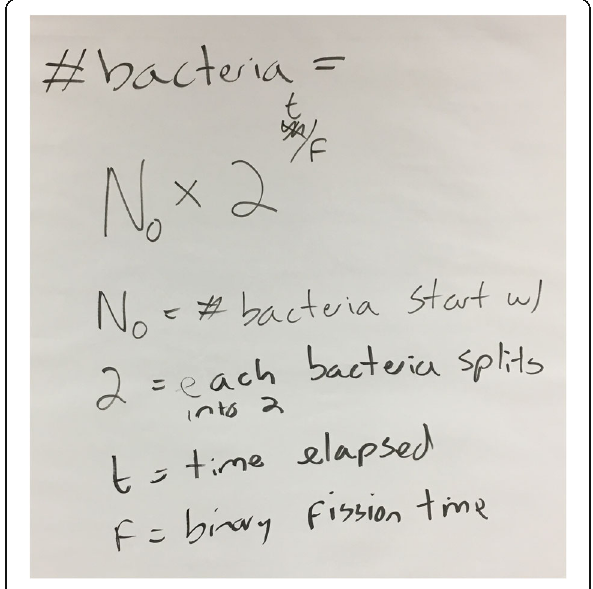
Fig. 4 Artifact from Dory ’ s instruction. The equation presented to students at the end of the activity on building a mathematical equation for growth of a single type of bacteria in the shaken culture (Note: Dory changed the exponent x to t to make the connection to the biological phenomenon more